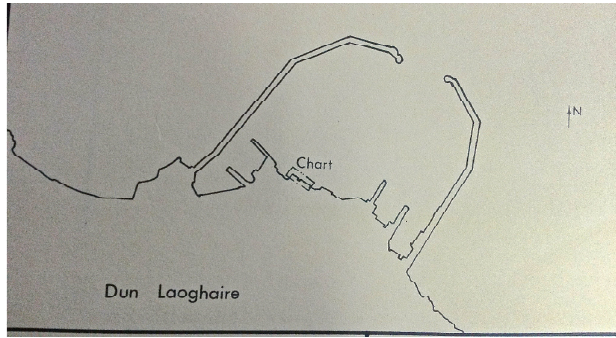
Figure 3. Map fragment, 2015 [1983]. © Silvia Loeffler, Glas Journal,